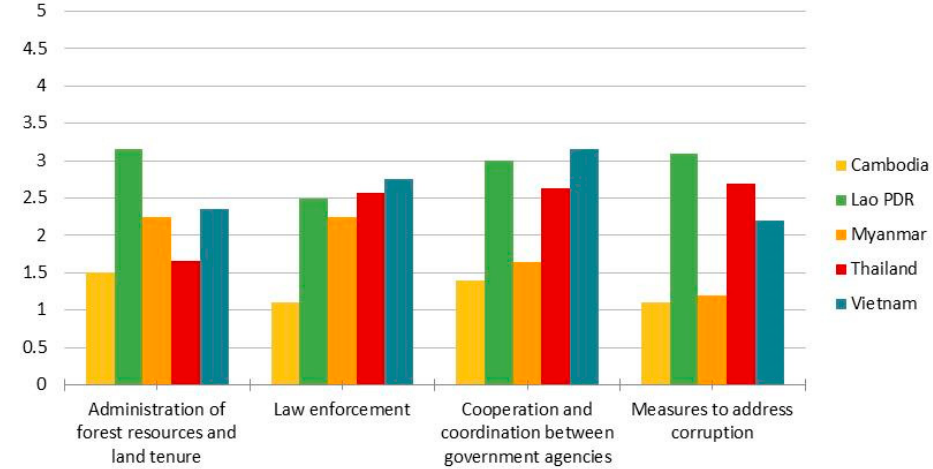
Figure 4. Average score per component of Pillar 3 for each country.